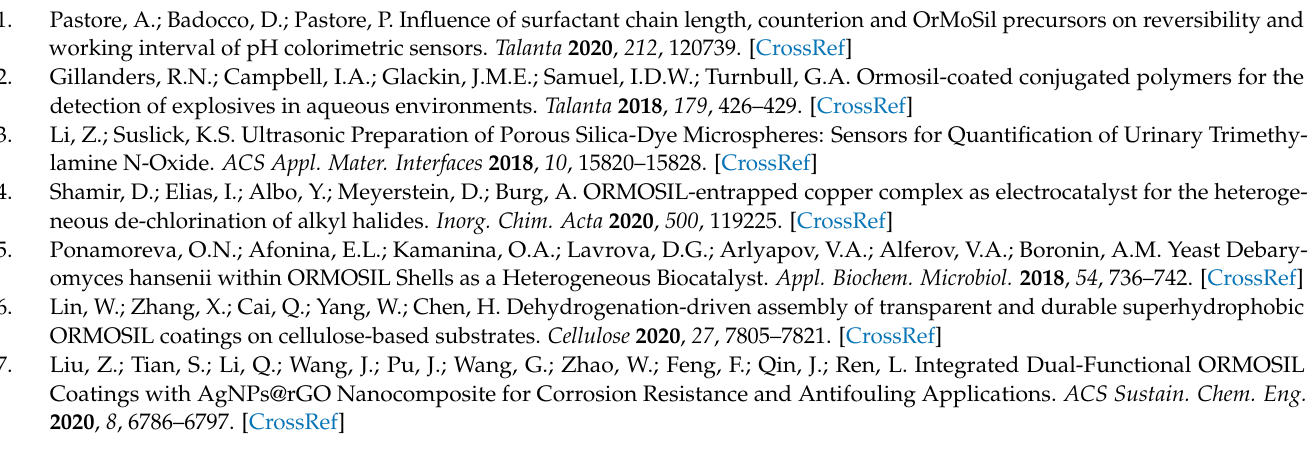
(SiO) 4 /(SiO) 6 and equations used for Figure 8 and Table